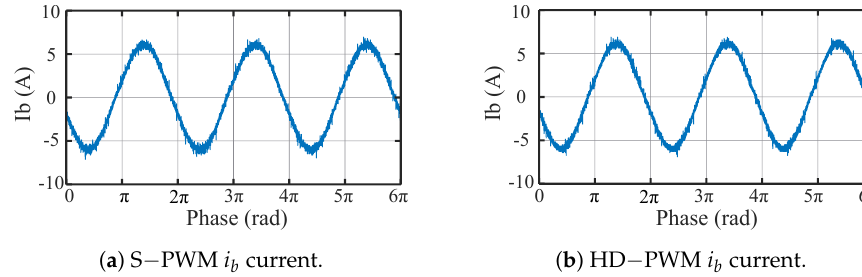
Figure 12. Current measurements ( M a = 0.85 and f sw = 18 kHz). Table 2. b -phase current harmonics’ amplitude percentage of studied modulation techniques. 1st Harm. 3rd